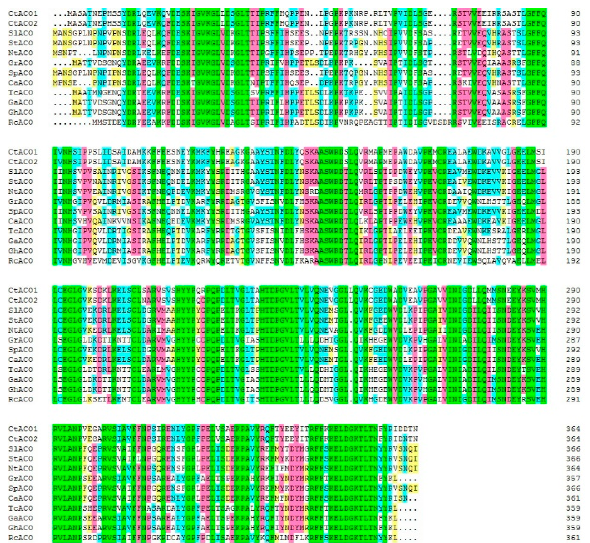
Figure 1. Alignment of Ct ACO1 and Ct ACO2 with ACOs （ 1-aminocyclopropane carboxylic